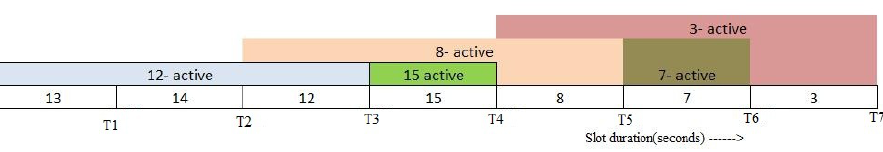
Figure 6. Slot allocation and parent node active state duration in DTS